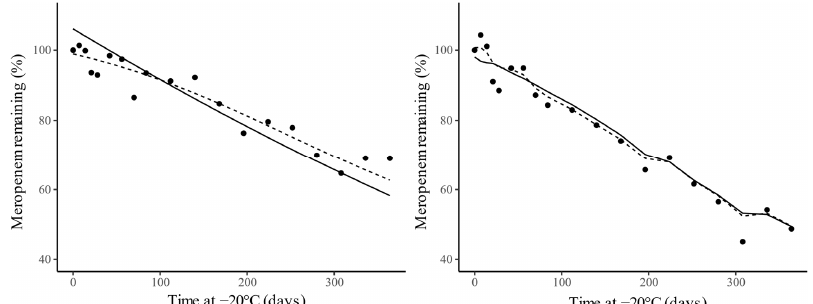
Figure 2. Simulation to assess the duration at which the lower 95% confidence interval crosses the critical threshold of 85% degradation (horizontal black line). Critical threshold values are shown in Table S1 (Supplementary Materials). It can be observed that significant degradation occurred relatively more rapidly with increasing concentrations. This effect ap- peared to stabilize at higher concentrations, resulting in the degradation becoming significant at around 80 days for con- centrations above 35.1 mg/L.